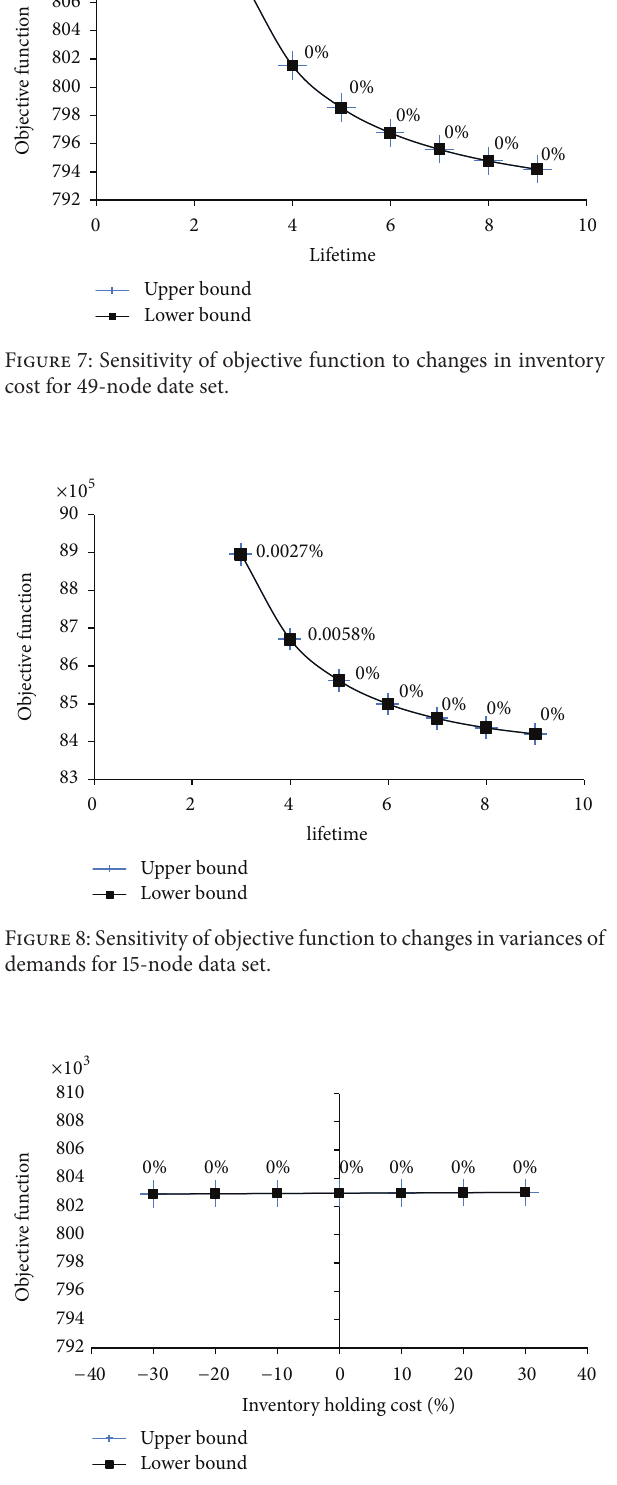
Figure 6: Sensitivity of objective function to changes in inventory cost for 15-node date set.